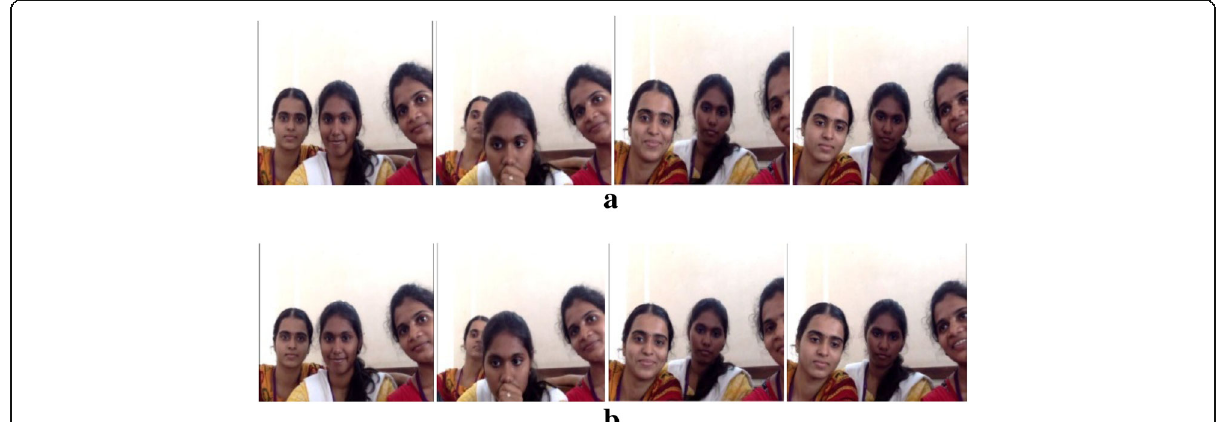
Fig. 10 Selected frames of live video streams. a Original frames. b Decoded frames